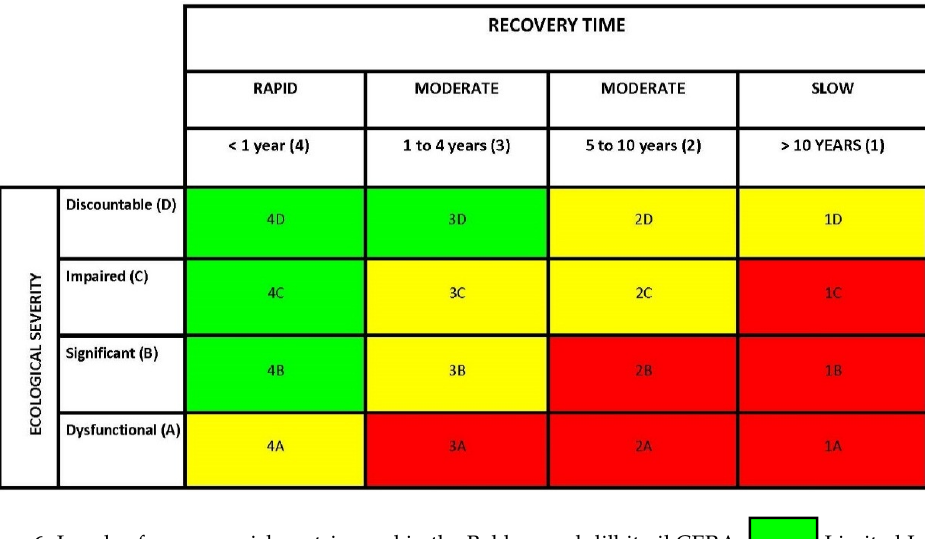
Figure 6. Levels of concerns risk matrix used in the Bakken and dilbit oil CERA. Limited Level of Concern; Moderate Level of Concern; High Level of Concern.